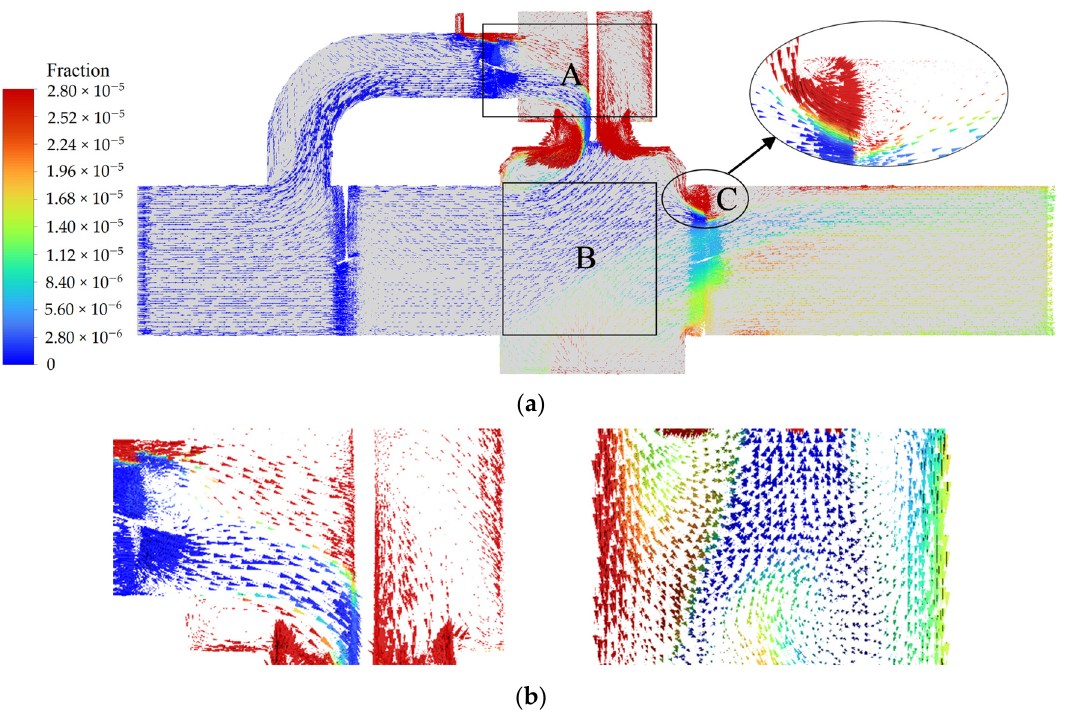
Figure 3. Flocculant mixing process; A, B and C are different mixing zones: ( a ) velocity vector distribution of flocculant; ( b ) vector plots of flocculant velocity on zones A (left) and B (right).